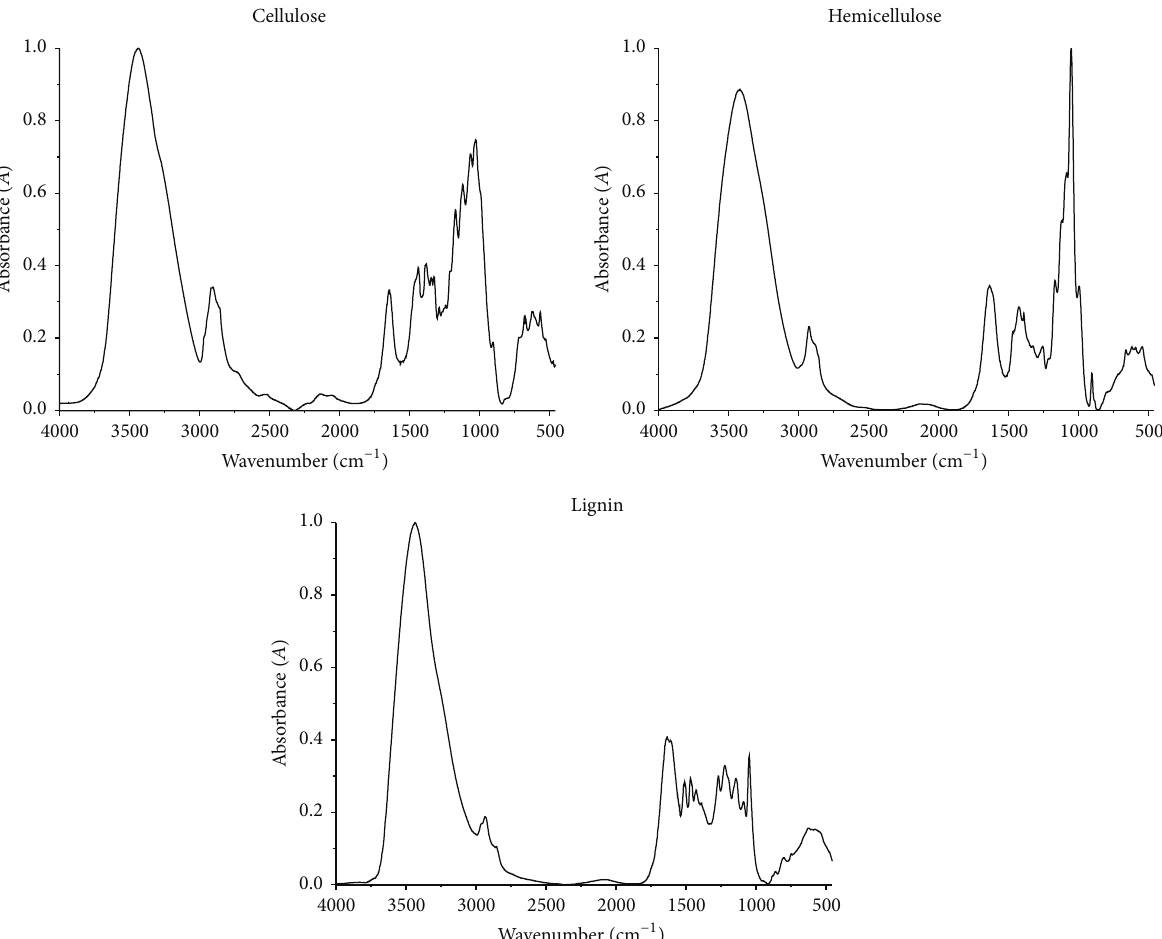
Figure 1: Reference FT-IR spectra for cellulose, hemicelluloses, and lignin. y -axis of the spectra is normalized to the maximum amplitude.